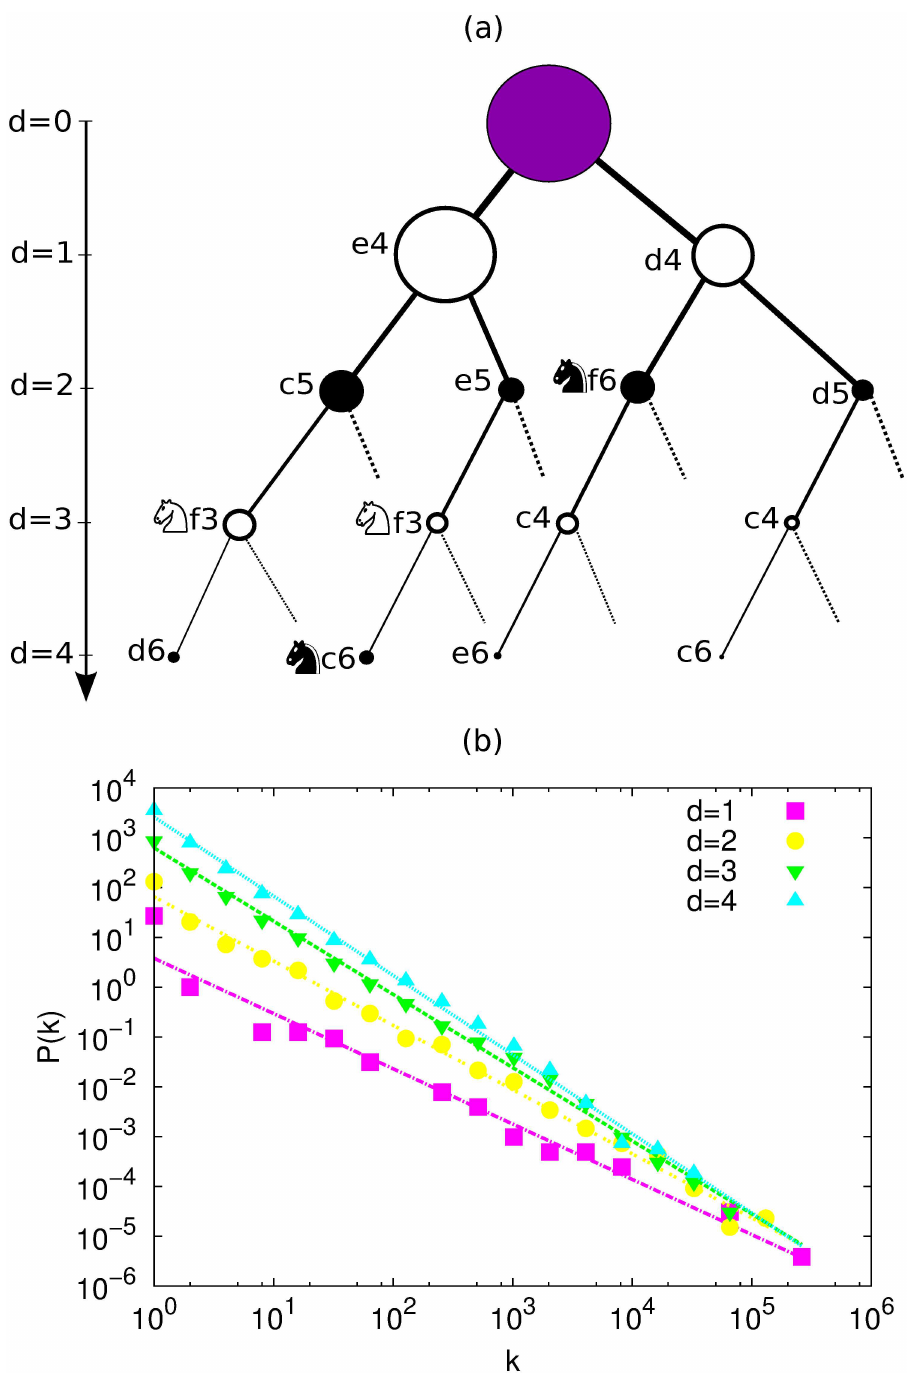
Fig 1. (a) Chess tree corresponding to the main opening-lines up to depth d = 4. The size of the nodesis proportional to their popularity. Here only the main lines are shown. (b) Distributionof popularities of the nodes at depth d = 1, 2, 3 and 4; these distributions are well fitted by power laws P ( k ) / k − α with α = 1.10 ± 0.05, 1.29 ± 0.03, 1.47 ± 0.02 and 1.59 ± 0.02 ( R 2 = 0.972, 0.993, 0.996 and 0.997), respectively. Errors estimated by the